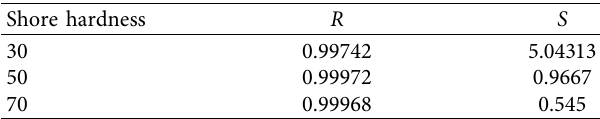
Table 2: Correlation coefficient and standard deviation of the three kinds of finger bending angle